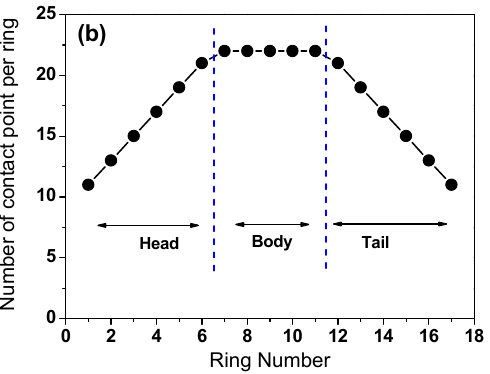
Figure 16. ( a ) Schematic and ( b ) measured number of contact point in wire ring along the moving direction of wire ring on a Stelmor conveyor roller.